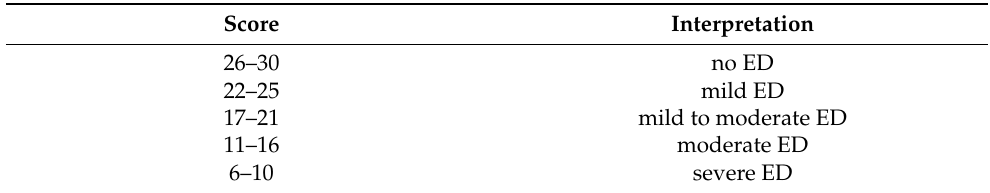
Table 1. Interpretation of IIEF—Erectile Function (questions 1 to 5, 15—processed after IIEF interpre- tation of Rosen 1997 and Cappelleri 1999).